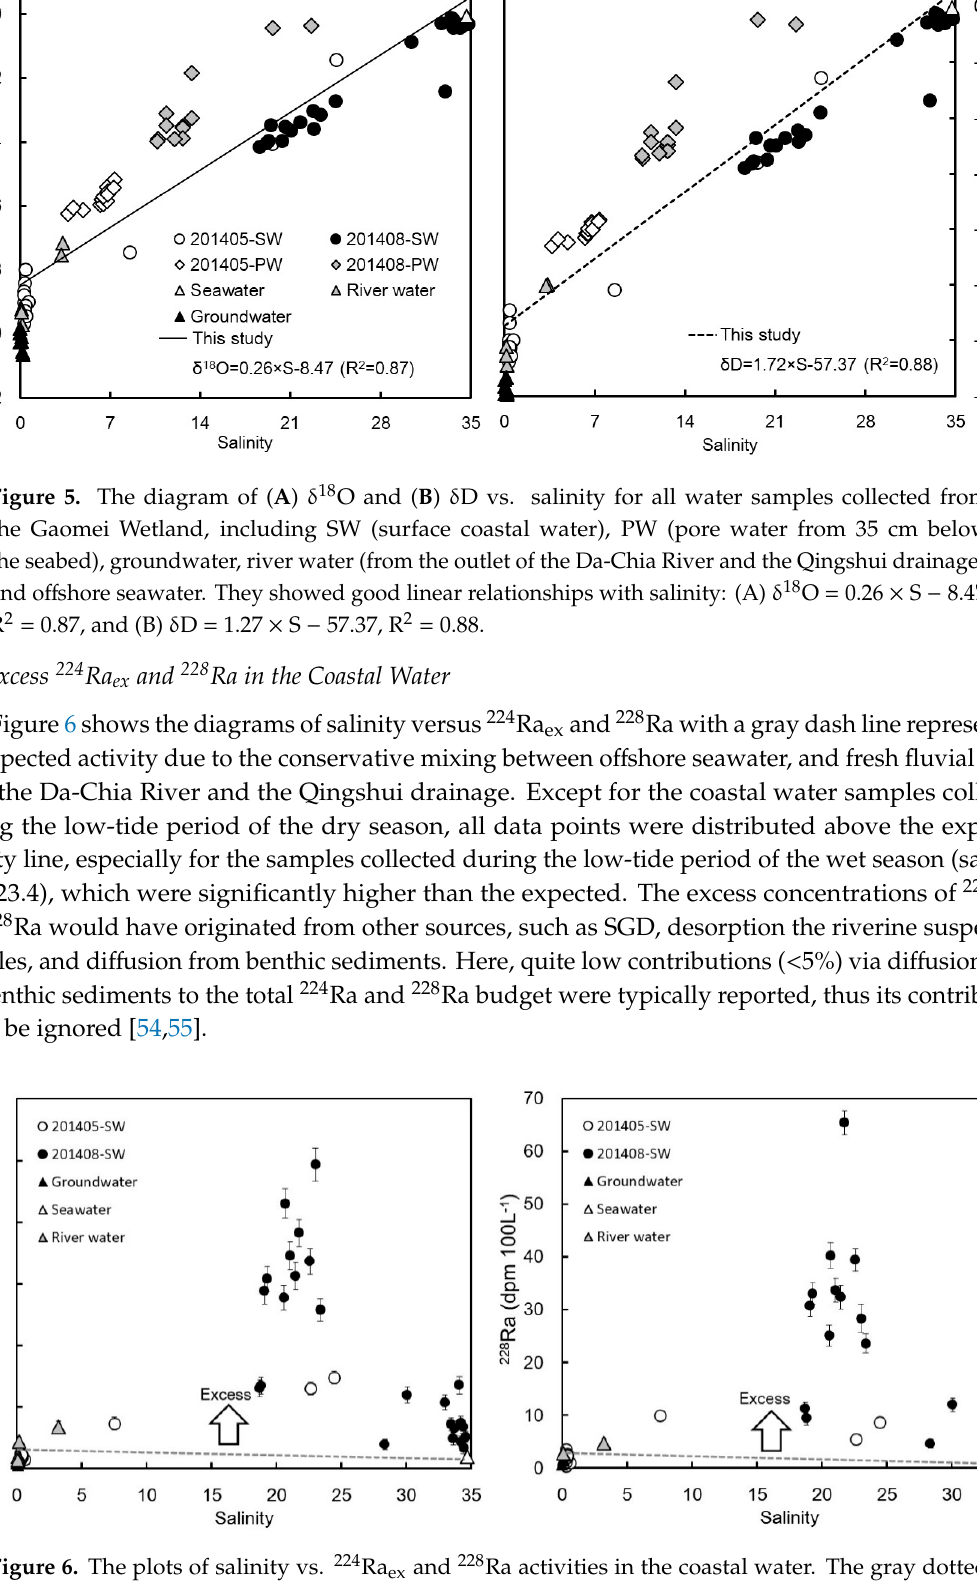
Figure 6. The plots of salinity vs. 224 Ra ex and 228 Ra activities in the coastal water. The gray dotted line represents the expected activity due to conservative mixing between fresh fluvial water and offshore seawater.